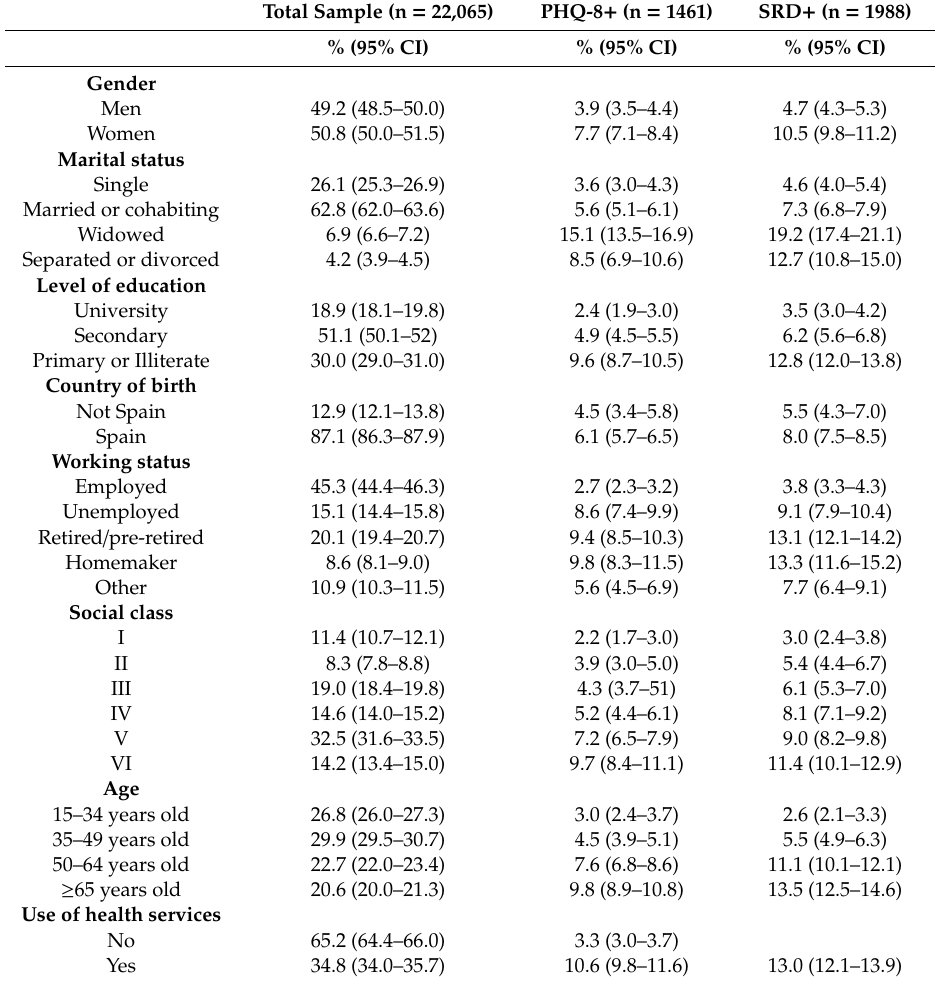
Table 1. Characteristics of the sample and prevalence of depression (Patient Health